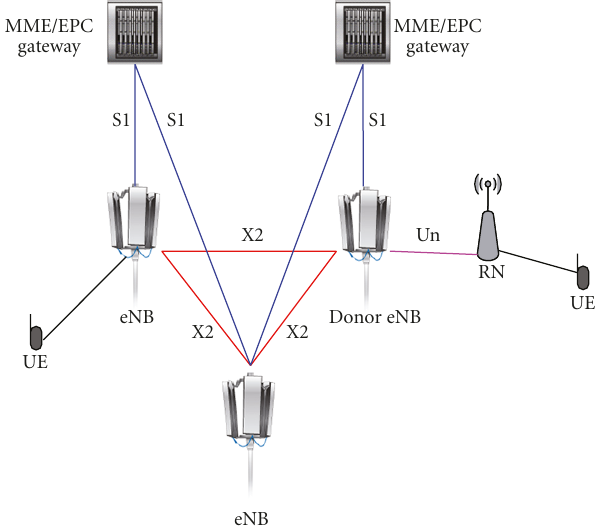
Figure 2: Architecture for relay enhanced LTE network with fixed RN